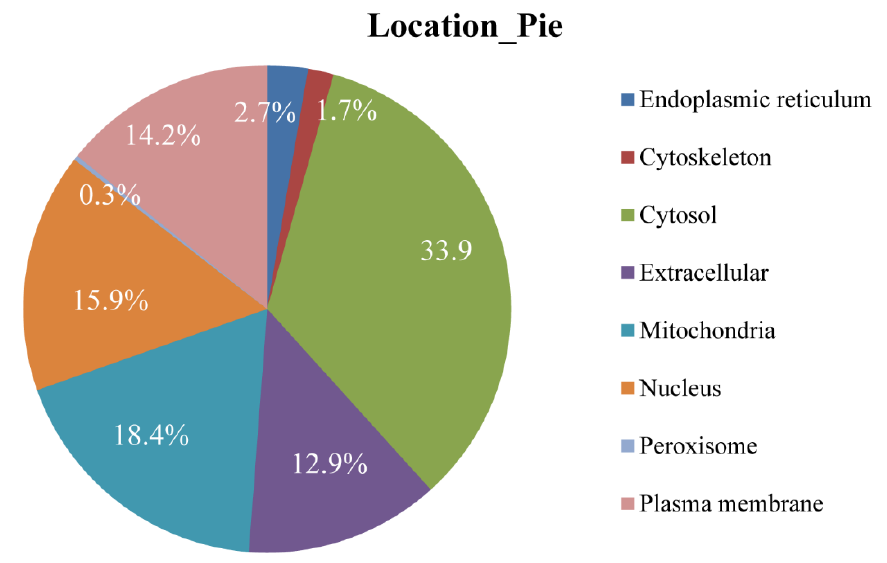
Figure 4. The subcellular location of DEPs identified in the Chinese mitten crab infected with P. gregaria